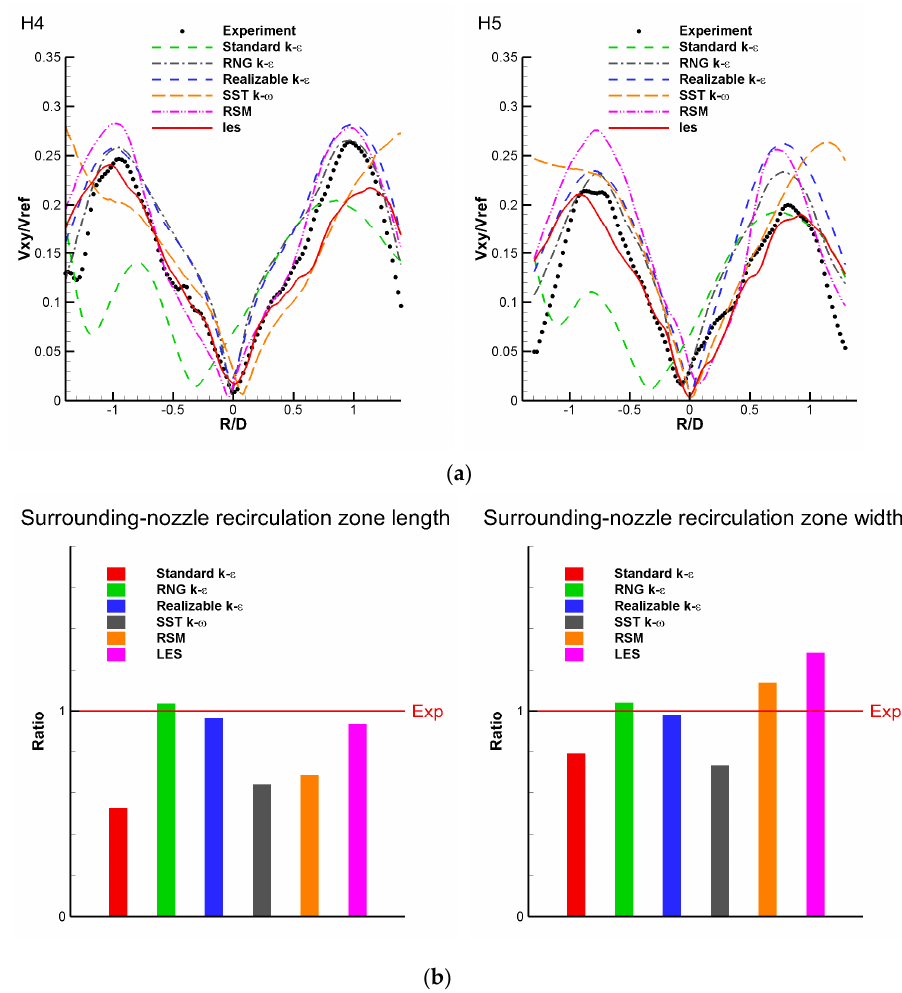
Figure 10. Comparison of different turbulence models. ( a ) V xy on selected diameter of H4 and H5; ( b ) Surrounding nozzle recirculation zone size.